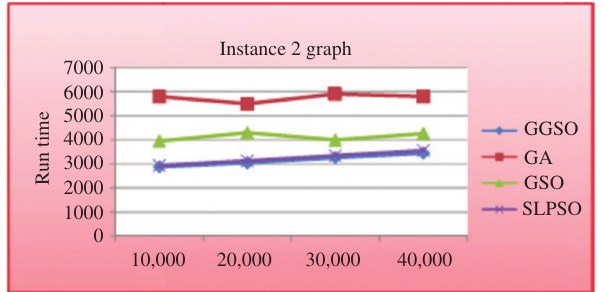
Figure 7: Runtime Performance of Instance